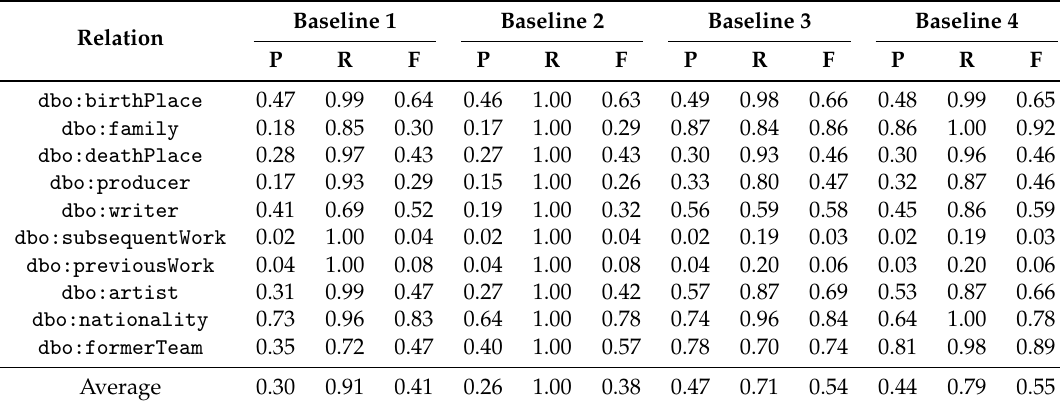
Table 5. Results of the four baselines on